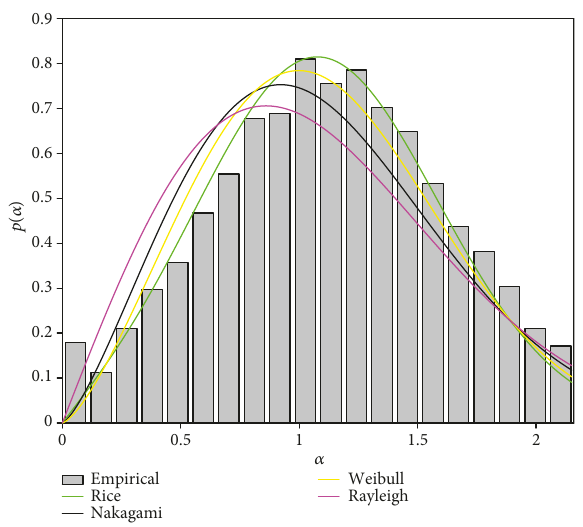
Figure 4: Exemplary fast fading distributions for C1 con fi guration and RX antenna placed on TO F